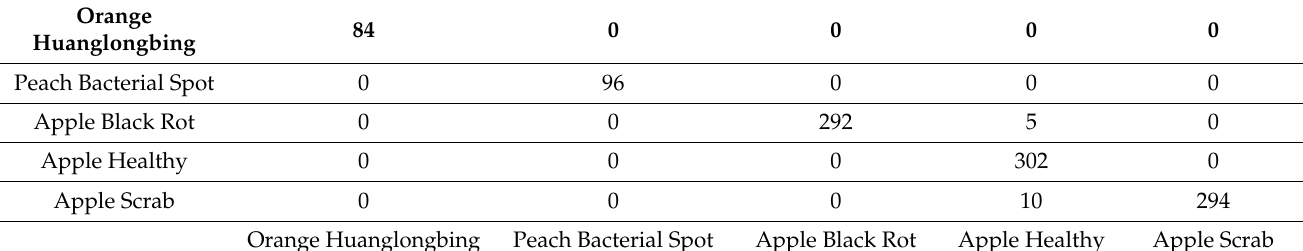
Table 5. Confusion matrix of top-5 classes.